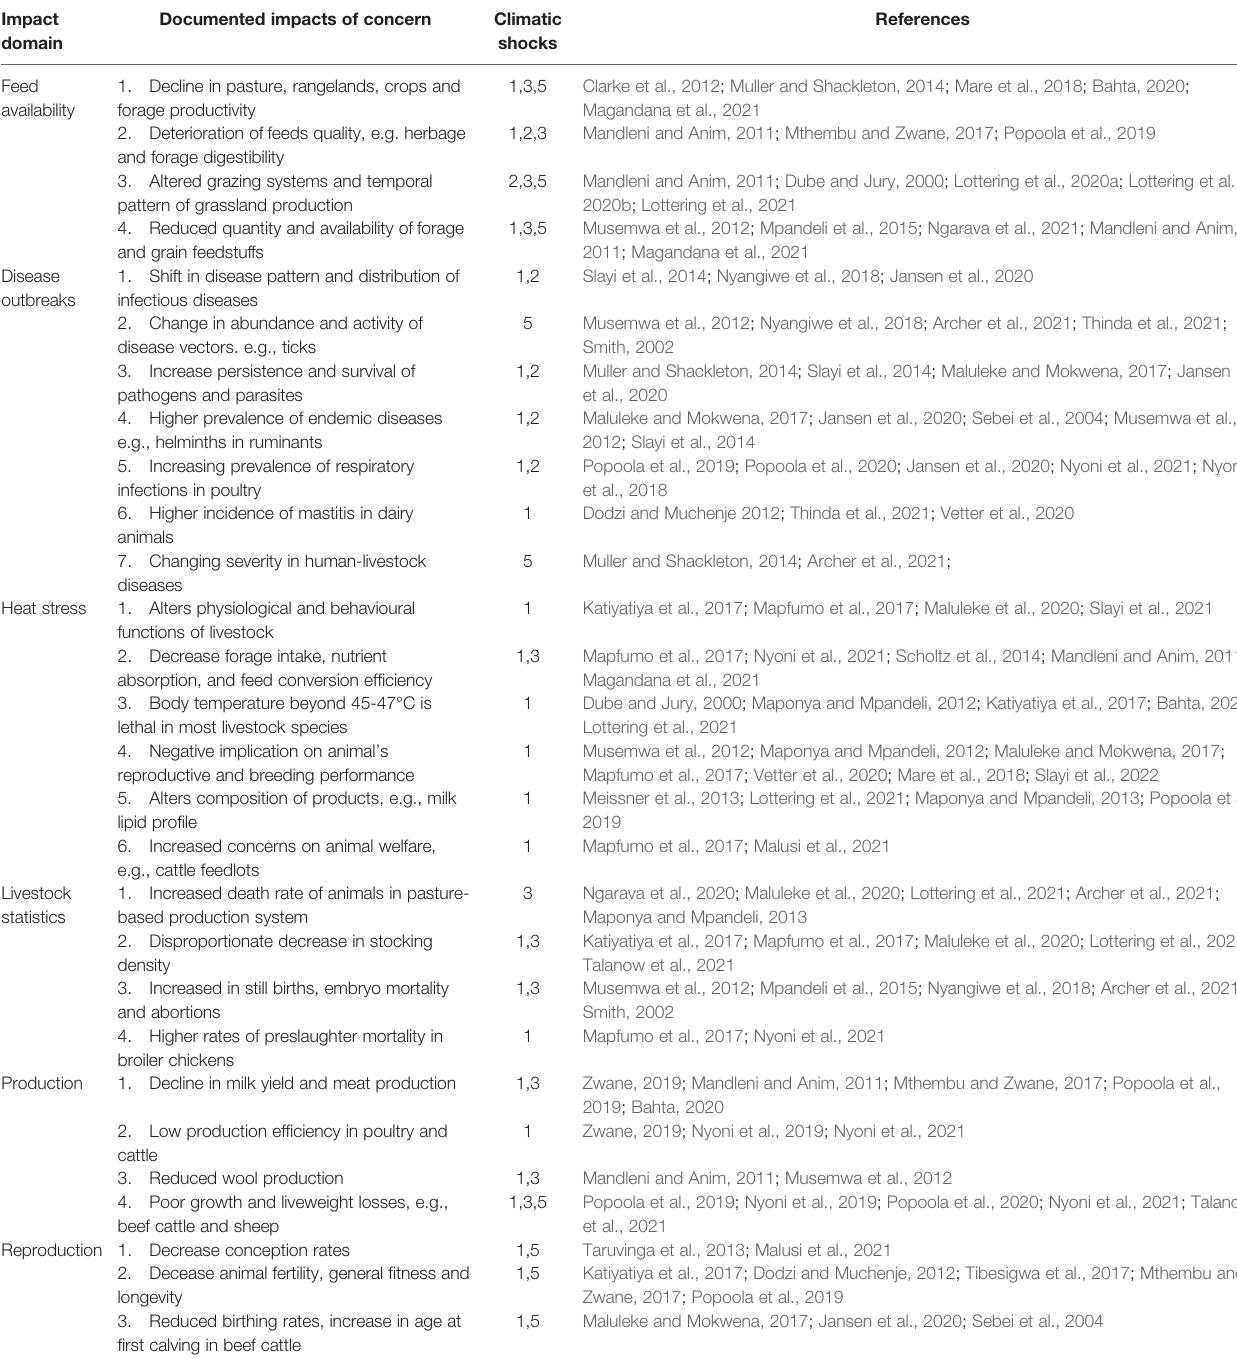
TABLE 1 | Framing the areas of concern highlighted on reviewed impact studies on climatic risks to livestock production in South